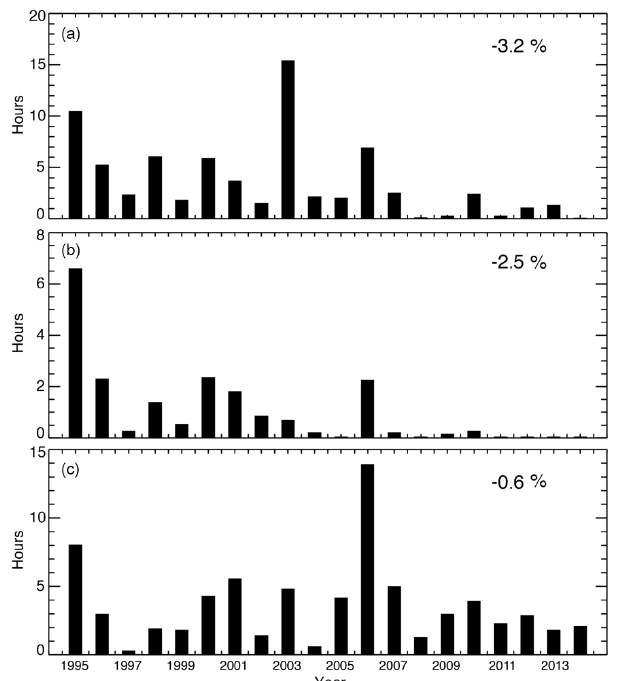
Figure 9. Annual observed (a) and modeled ( b : control simulation; c : constant emission simulation) exceedances of the information threshold (1-hourly averages: 180µgm − 3 ) . The hours along the y - axis should be multiplied by 100.